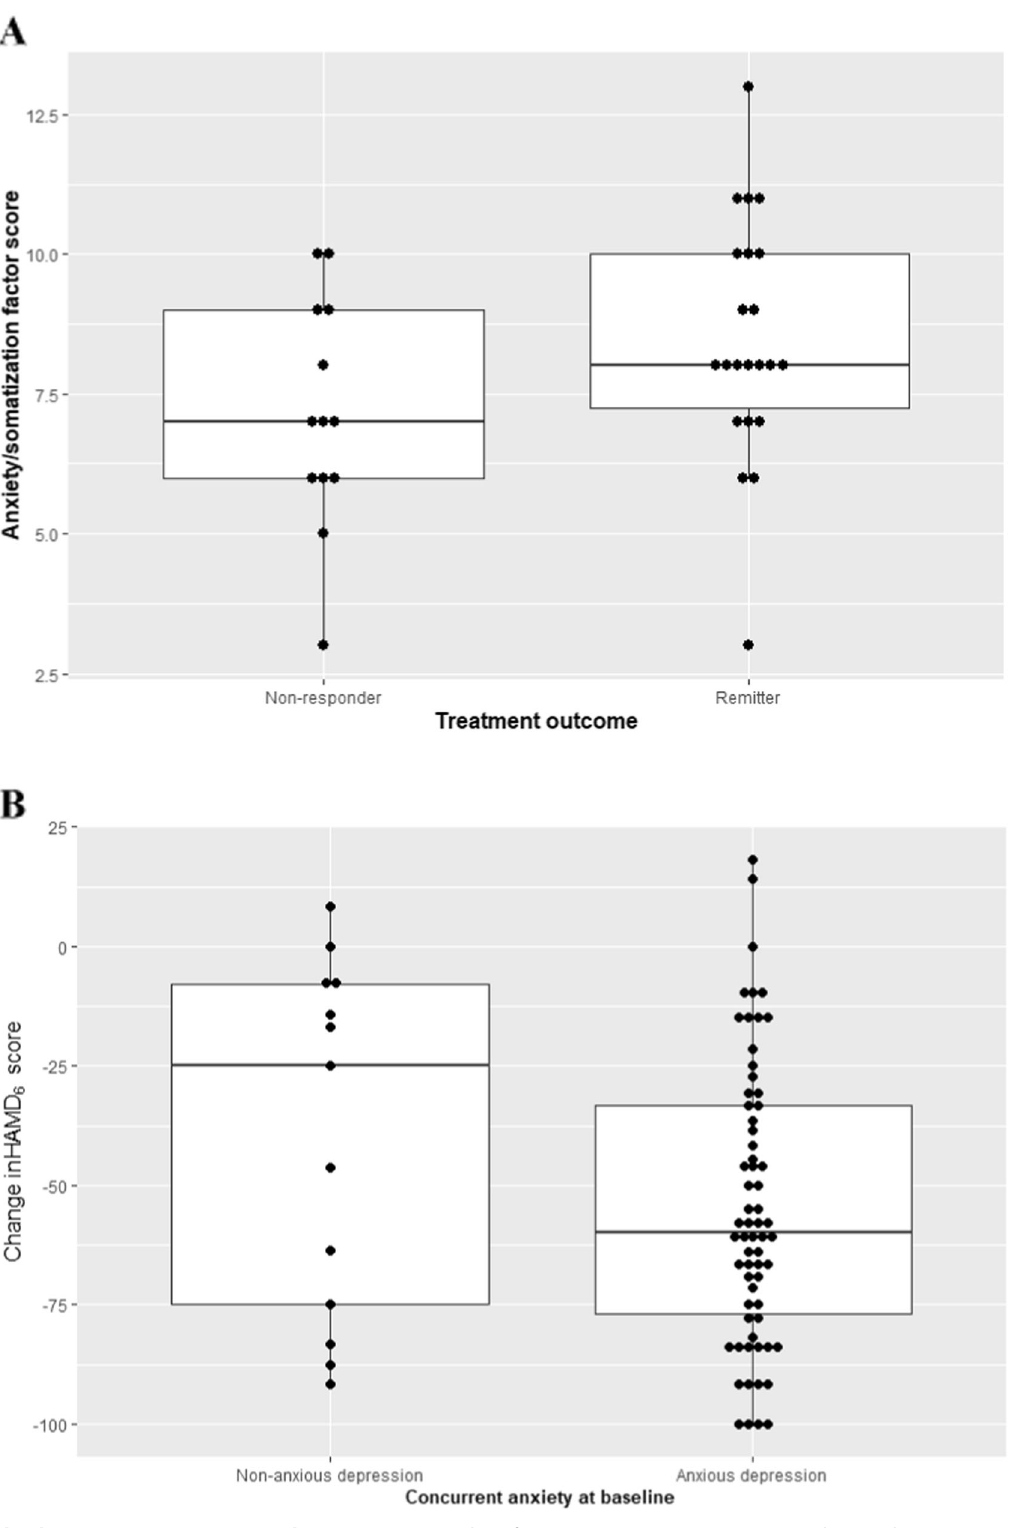
Fig. 3 Longitudinal outcomes in anxious and remitters. A Baseline factor score in MDD non-responders and remitters as de fi ned after 8 weeks of treatment. B Change in HAMD score from baseline to week 8 in patients with concurrent anxious vs. non-anxious depression at